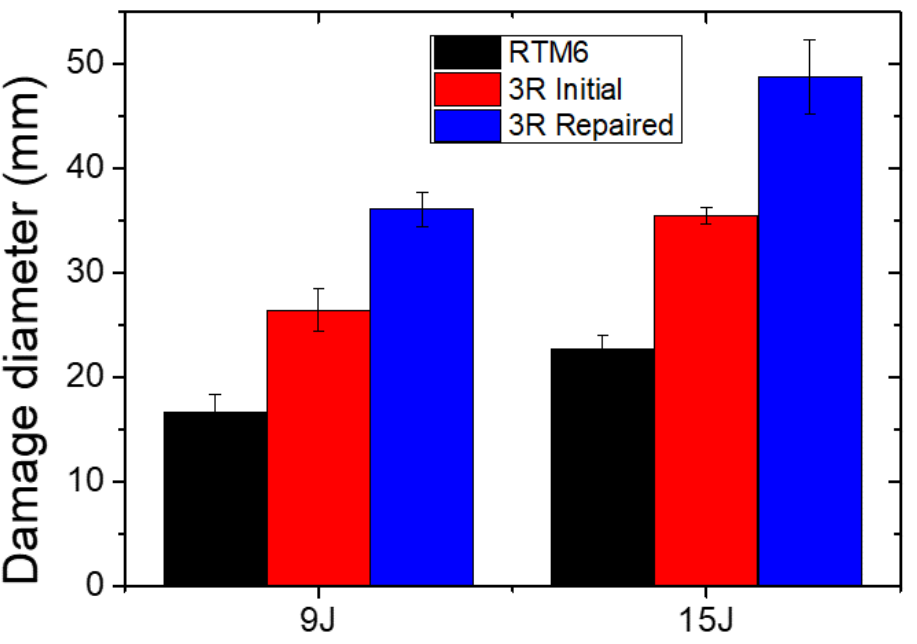
Figure 22. Damage diameter comparison.